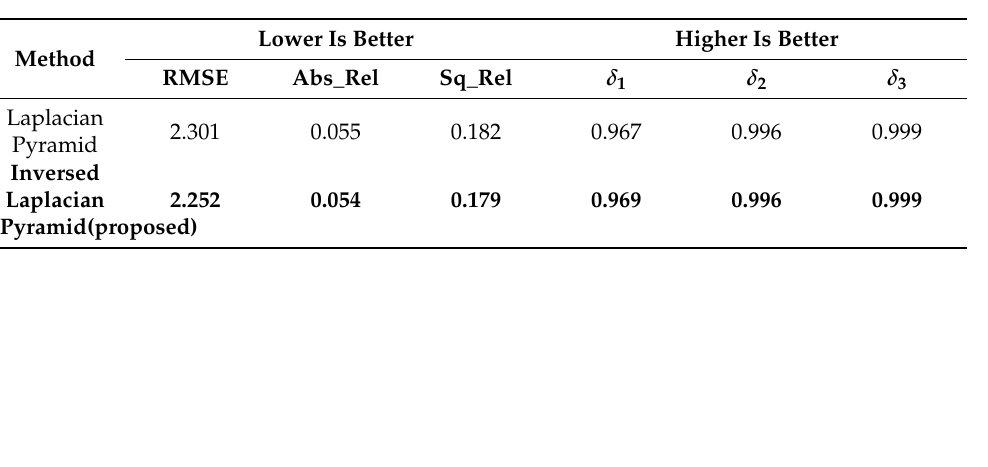
Table 9. KITTI Eigen split evaluation results with different Laplacian Pyramid methods (except the Laplacian Pyramid, other environments are the